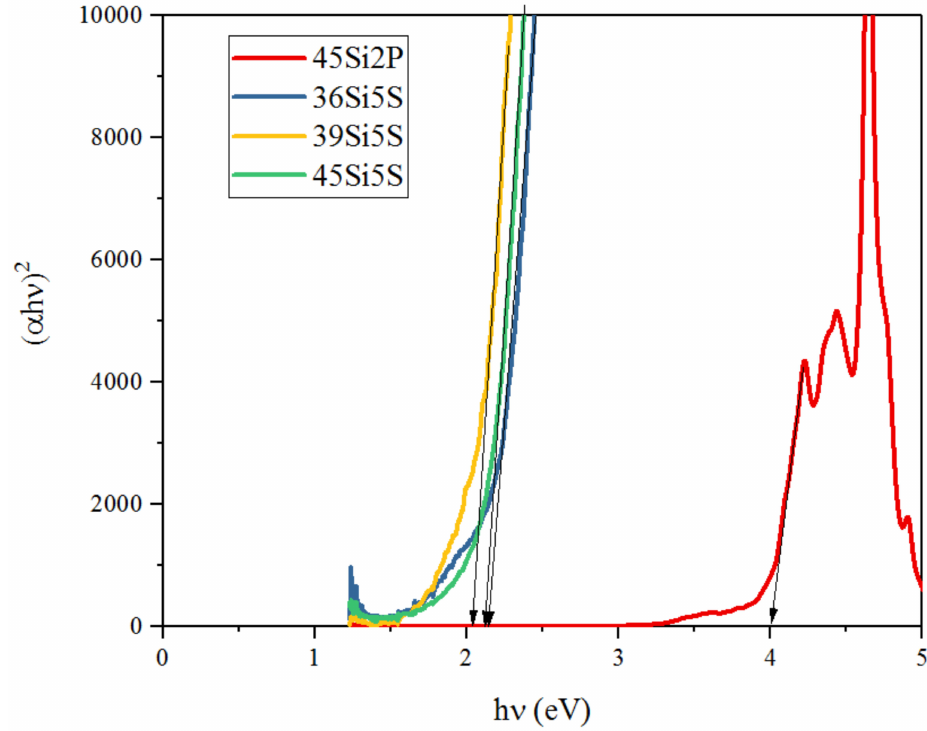
Figure 13. Tauc plot for the silicate–phosphate glass samples: 36Si11P5S, 39Si8P5S, 45Si2P5S, and 45Si2P; n = 2.